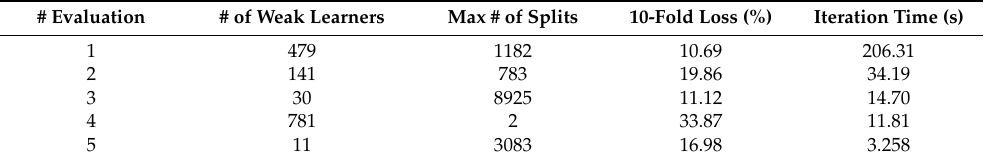
Table 3. Number of weak learners (trees) and maximum number of splits optimization based on 10-fold cross-validation loss